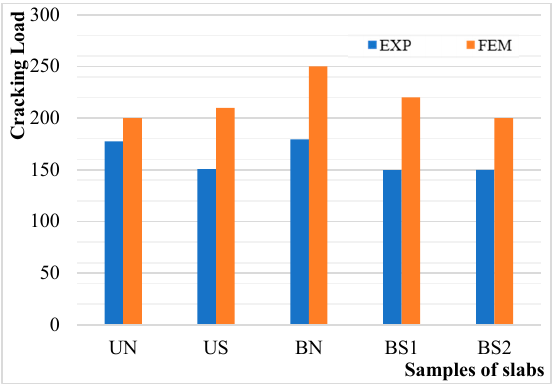
Figure 25. Cracking load comparison between FEM and EXP.